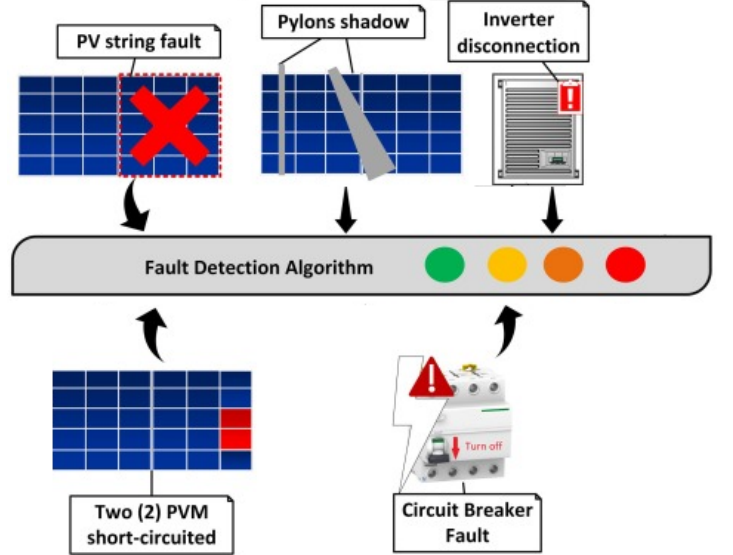
Figure 12. Considered anomalies in this study.